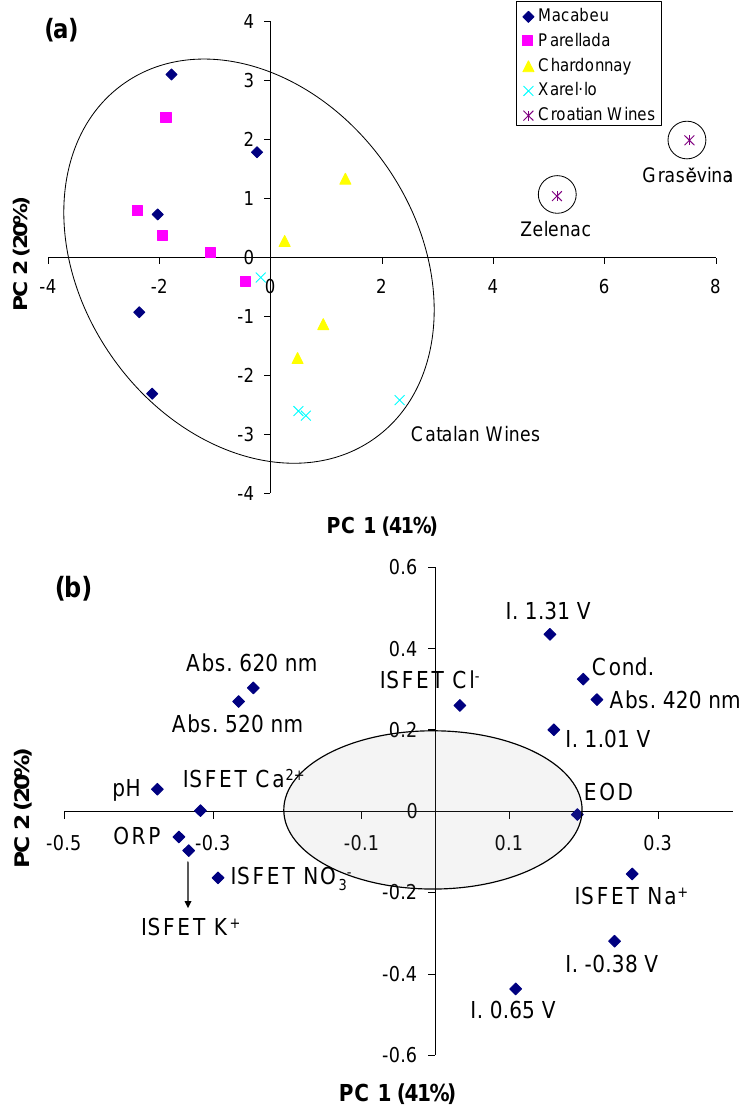
Figure 4. PCA results for the 20 monovarietal wine samples: ( a ) scores plot and ( b ) loadings plot with a grey circumference which corresponds with the zone of low